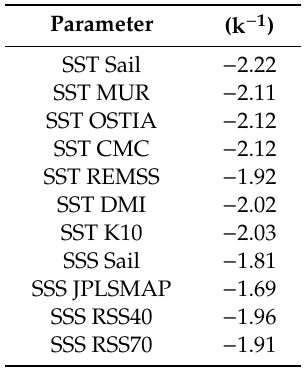
Table 3. Wavelength spectral